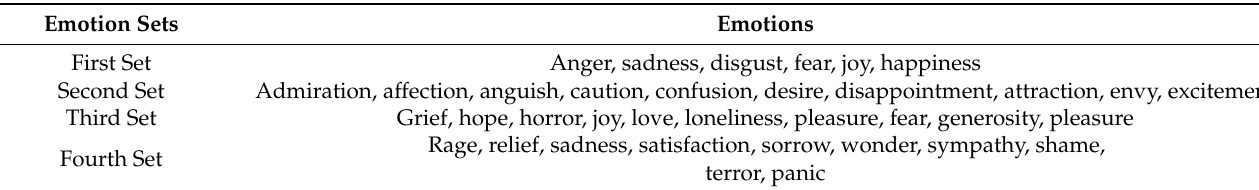
Figure 1. Workflow of the proposed semi-supervised method for sentiment classification. It in- cludes two stages (phases), which combine unsupervised classification for recognizing emotions in a text, and supervised classification for detecting sentiments from emotions. Figure 2. Two stages of the proposed semi-supervised method. The first stage uses unsupervised zero-shot learning by sentence transformers to obtain emotion probabilities. The second stage uses supervised ensemble learning to learn sentiments from emotion probabilities.